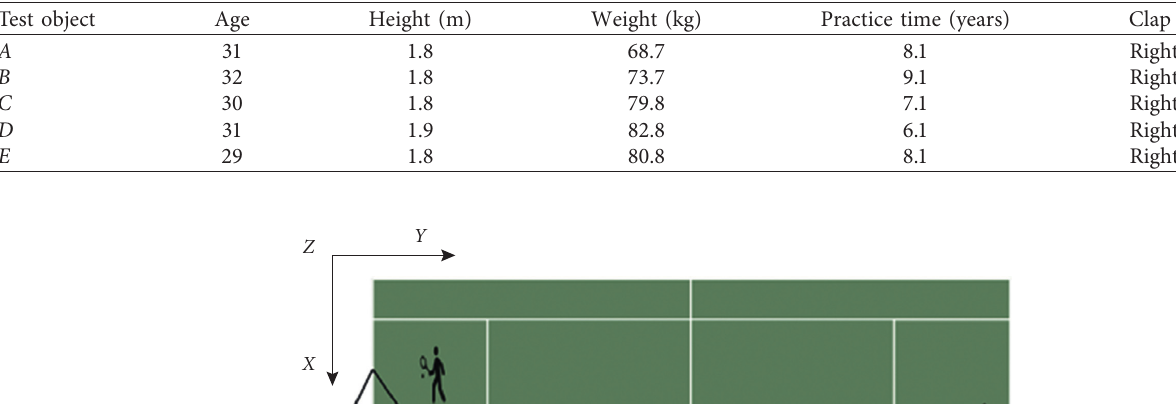
Table 1: Research object information table.